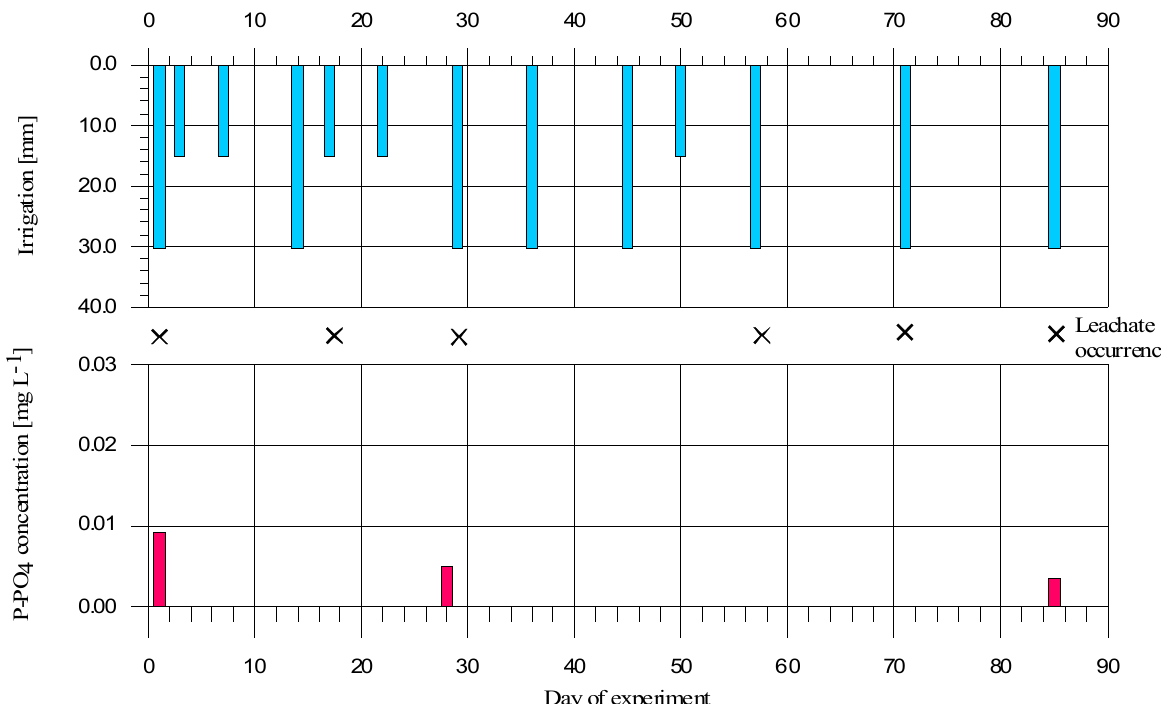
Figure 6. Irrigation rate, leachate occurrence and P-PO substrate of extensive green roof underlined with drainage layer made of AAC—result from column experiment (note: vertical scale of Figures 4 and 5 are